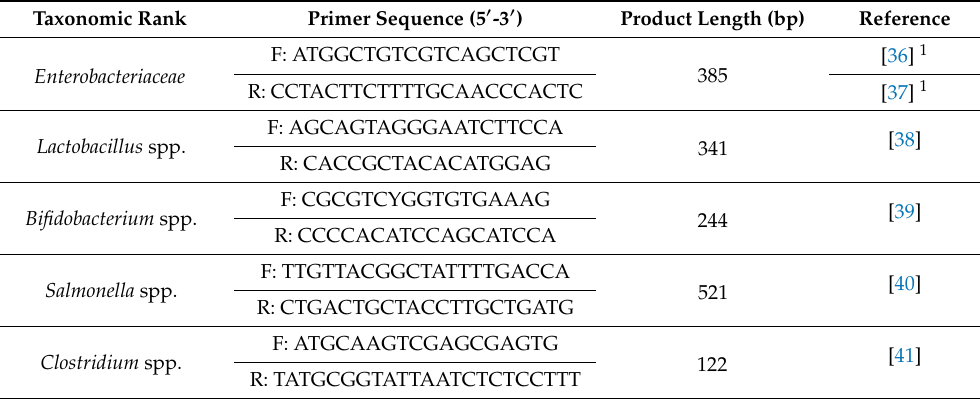
Table 2. Primer sequences used for the real-time PCR